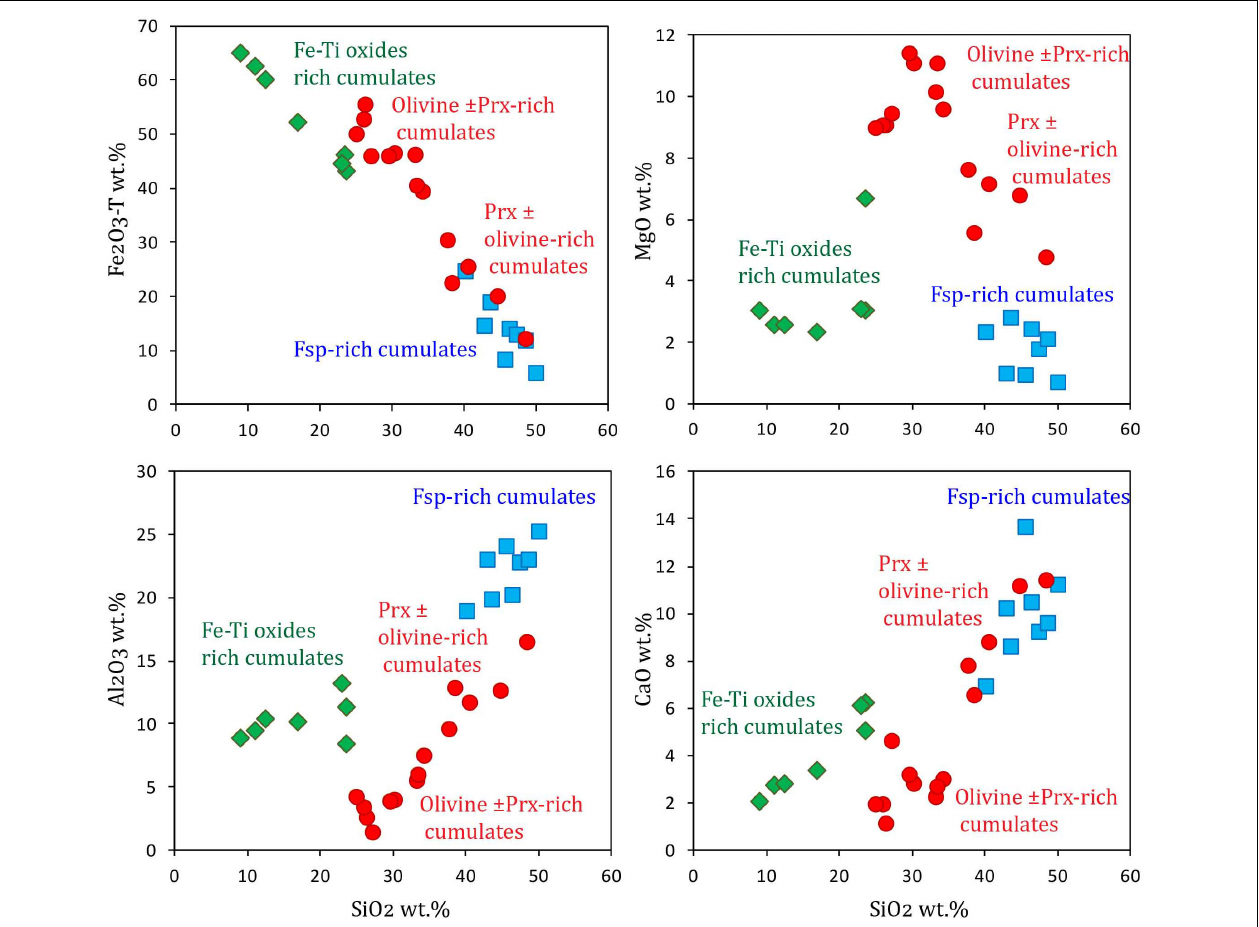
FIGURE 2 | Harker diagrams for the samples (Nebel et al., 2013b) indicating the modal mineralogy of the cumulate layers. Grouping of samples in these plots is defined by the dominant mineralogy with one group being dominated by olivine and pyroxene, one by feldspar and one by Fe-Ti